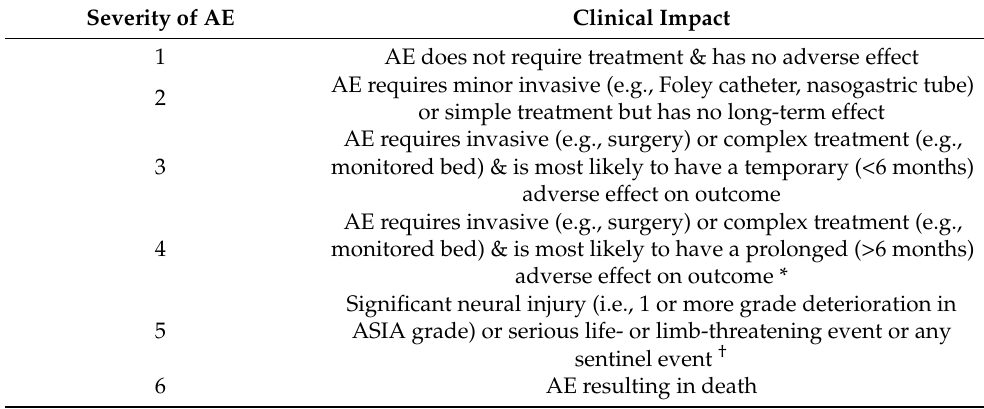
Table 1. SAVES-V2 severity